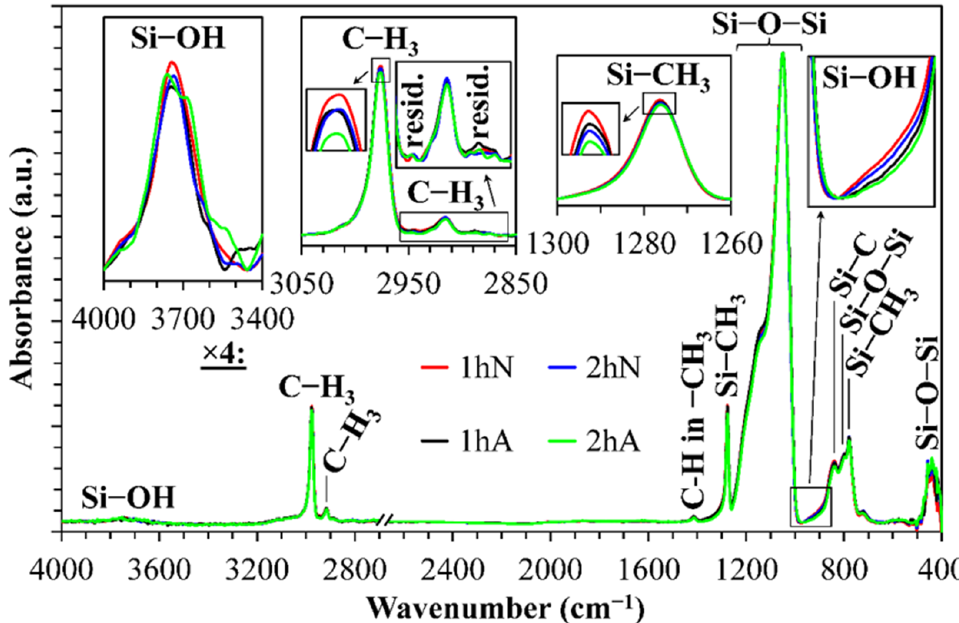
Figure 3. FTIR spectra of low-k films deposited and studied in this work: after hard-baking at 400 °C for 1 and 2 h in nitrogen (1 hN and 2 hN) and air (1 hA and 2 hA). The most pronounced peaks in the FTIR spectra are related to the silica-like matrix (Si-O-Si stretching vibrations at 1200–1000 cm − 1 ) and to the terminal Si-CH 3 groups (~1275 cm − 1 ) and are typical for various OSG low-k films [4,5,9]. The concentration of the Si-CH 3 groups was almost the same after different curing conditions, which suggests that all samples were cured near an optimal condition. Fully cured samples were free of the CH and CH 2 bound fragments (about 2870 cm − 1 and 2930 cm − 1 ) that usually form from incompletely removed porogens. Some differences in the fully cured films can be seen in the peaks related to the C-H vibration at 2975 cm − 1 . This peak is mainly associated with the Si-CH 3 groups. One can see that the samples cured for 1 h (1 hA) in air and 2 h in nitrogen (2 hN) were fully identical. The sample cured for 1 h in nitrogen (1 hN) had the highest carbon concentration, while the samples cured for 2 h in air (2 hA) had the lowest. These observations allow us to assume that the 1 hN sample contained some remaining carbon residues, while the 2 hA sample was completely cured. All studied samples contained a trace amount of silanol groups (Si-OH absorption near 3700 cm − 1 ), but the difference between differently cured samples was very small. All four films had similar porosity. The very small difference was related to the open porosity: 36.4% for the 1 hN and 1 hA samples and 36% and 35.9% for the 2 hN and 2 hA samples, respectively (Table